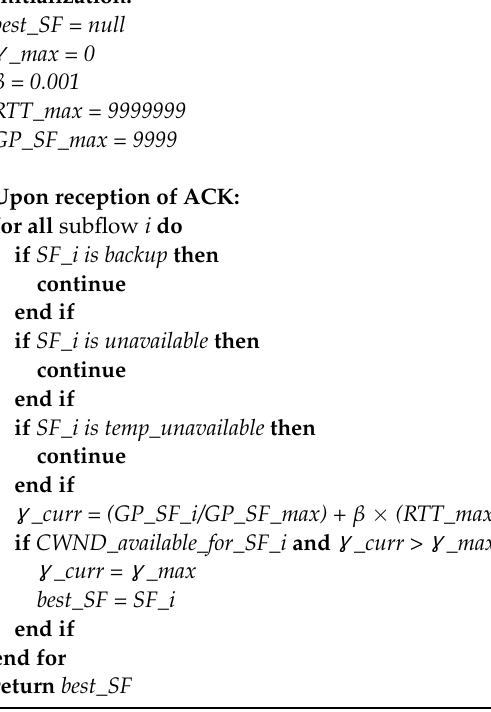
Algorithm 1: Low latency and high data rate (LLHD) Scheduling algorithm